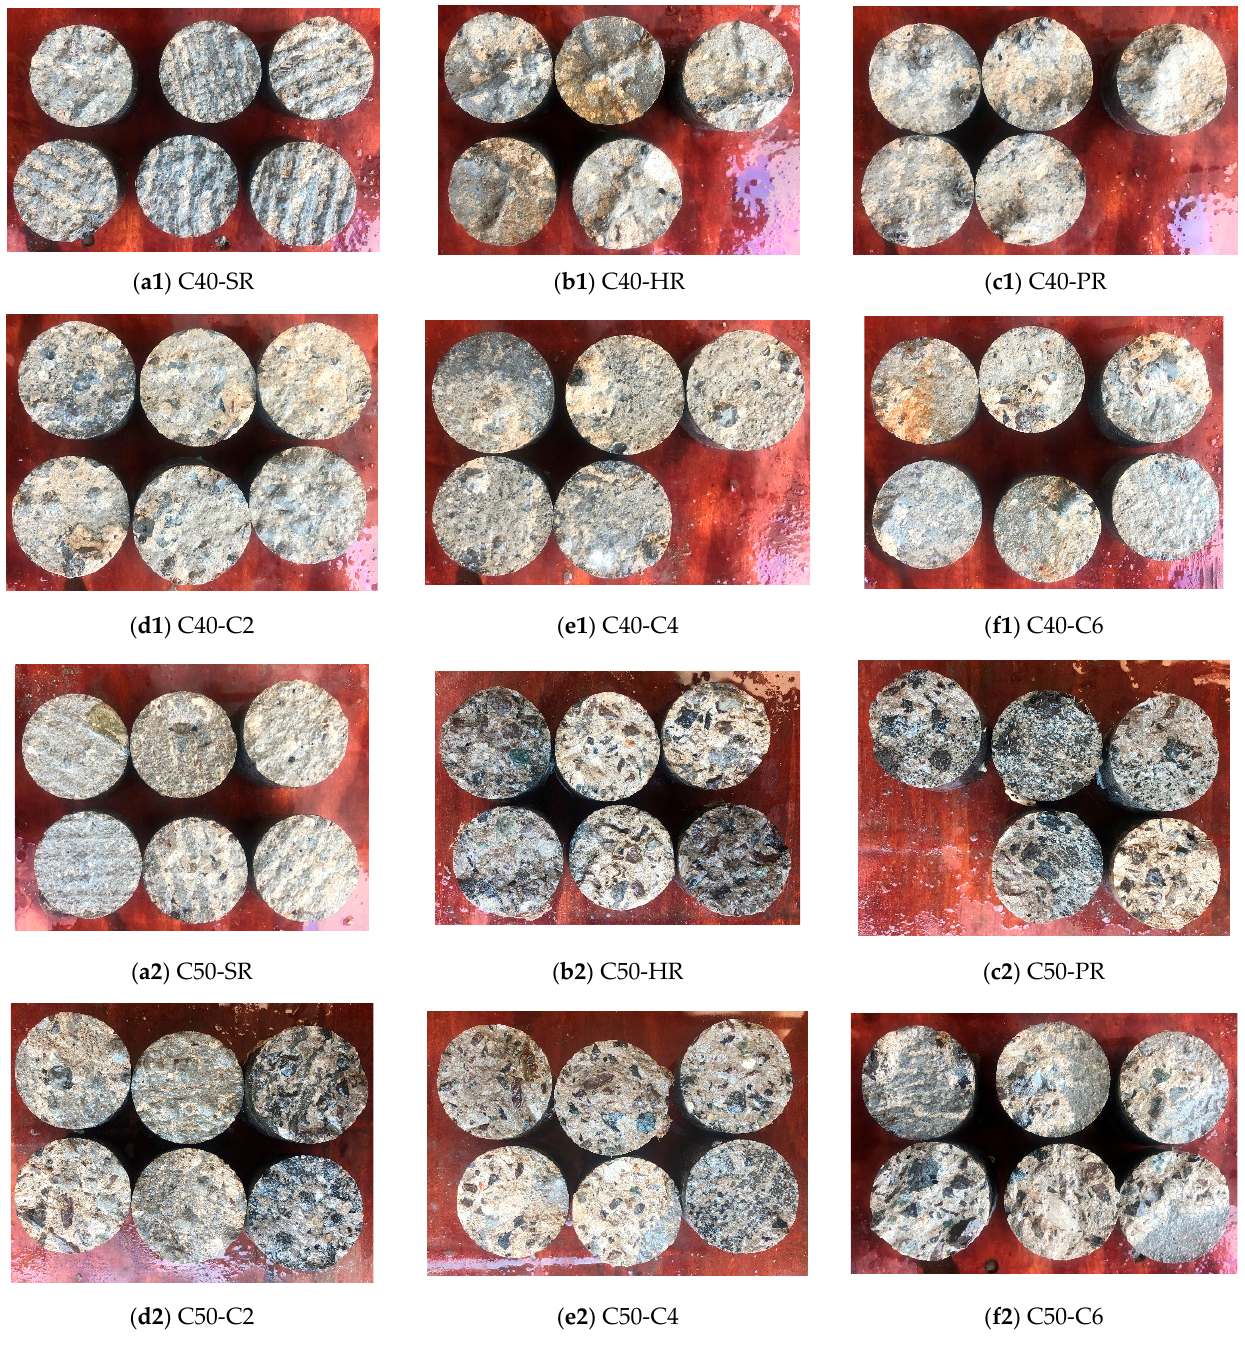
Figure 7. Fracture sections of the pull-o ff samples.